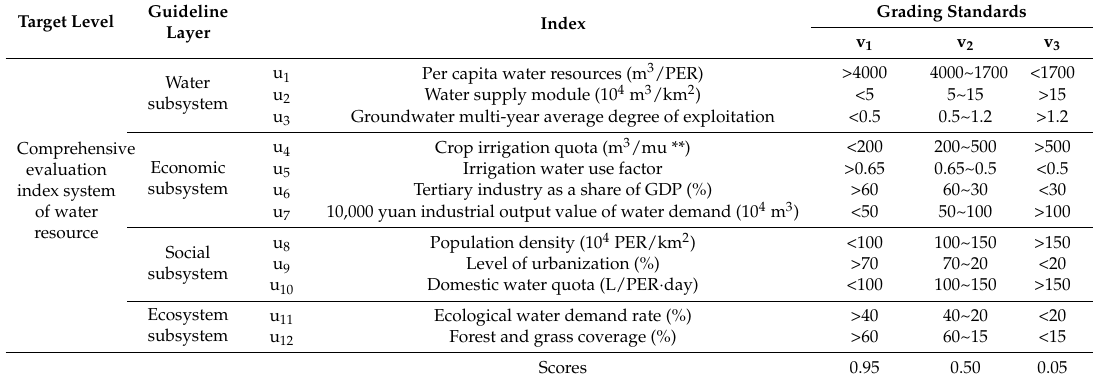
Table 4. The evaluation system and grading standard of water resource carrying capacity